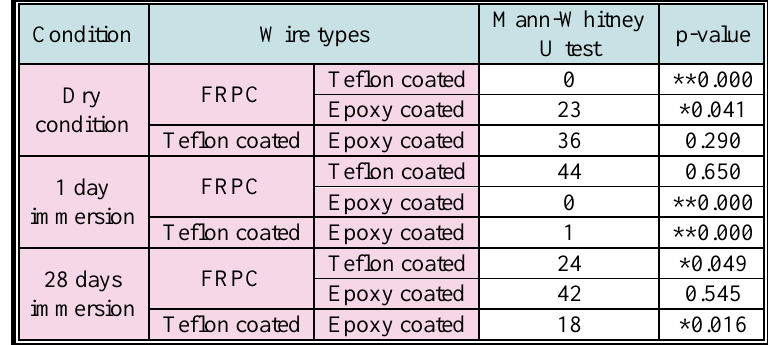
Table 4: Differences in Ry of different types of esthetic wires at eachimmersion period.